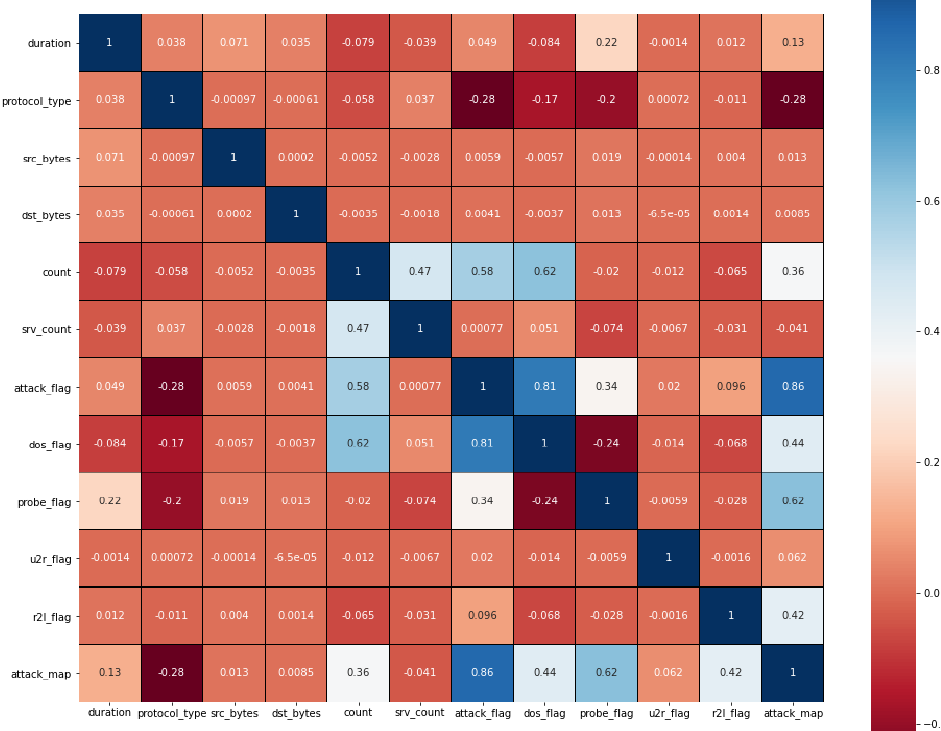
Figure 10. Heatmap illustrating feature importance and correlation.